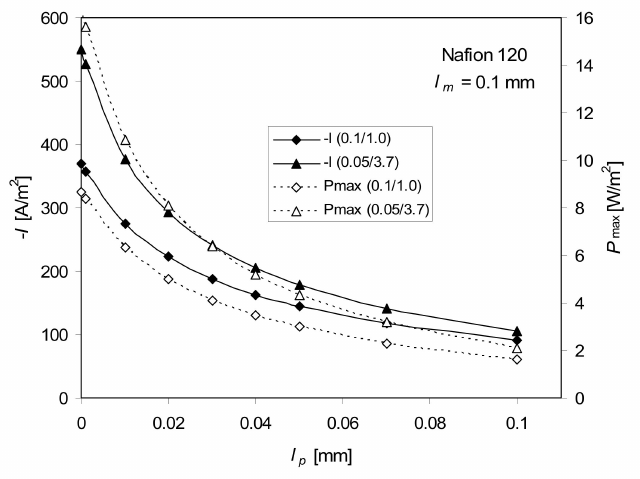
Figure 6. Dependence of the maximum of power density, P max , and the current density, − I , at P max on the di ff usion boundary layer thickness, l p , for 0.1–1.0 M and 0.05–3.7 M NaCl, T = 298 K, Equation (5), full ITE.